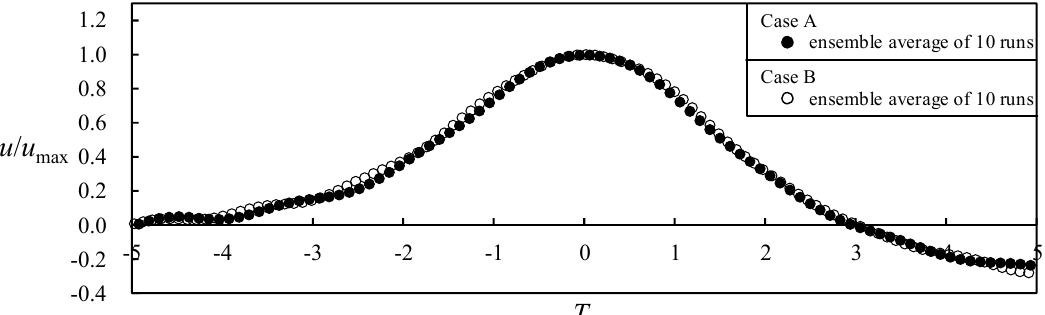
Figure 4. Comparison of the temporal variation of the non-dimensional horizontal velocity between Case A and Case B measured at ( x/h 0 , y/h 0 ) = (0, 0.94).